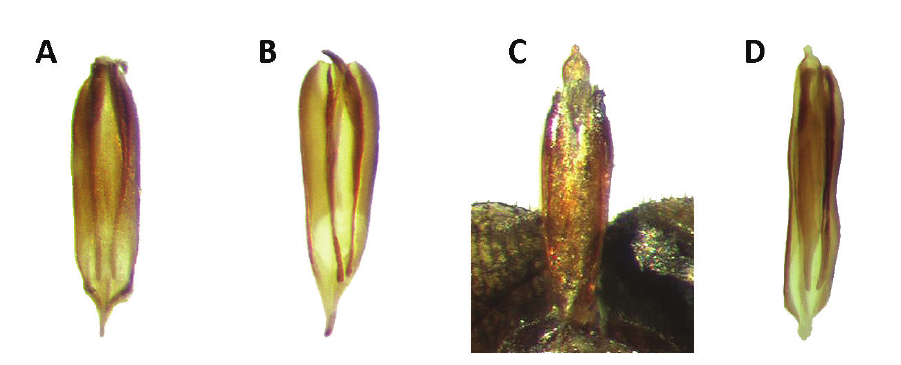
Figure 7. Aedeagus of: A Neocallotillus elegans ( C. e. elegans ) B N. elegans ( C. e. vafer ) C N. intricatus ( C. intricatus ) D Callotillus